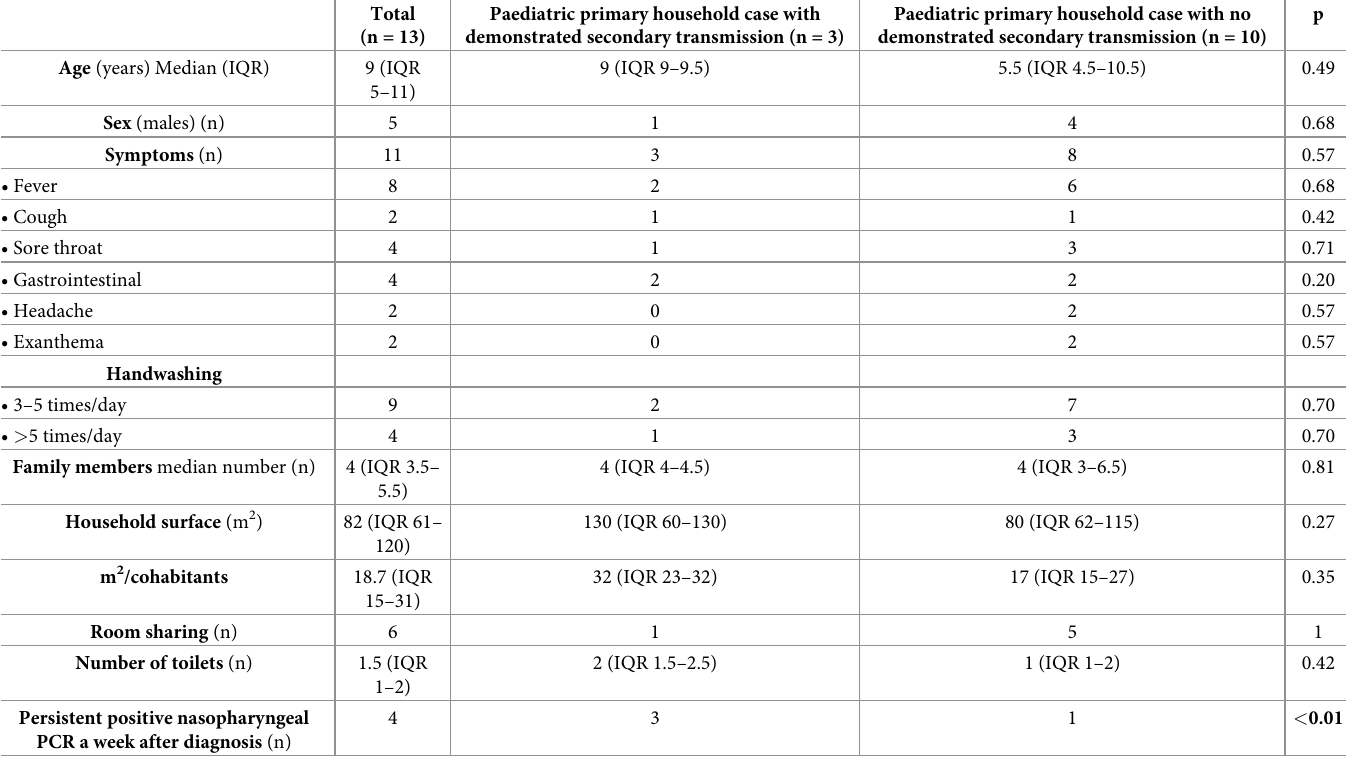
Table 2. Comparison of demographic, clinical, and analytical variables of paediatric patients who transmitted the infection to other household members and those who did not transmit